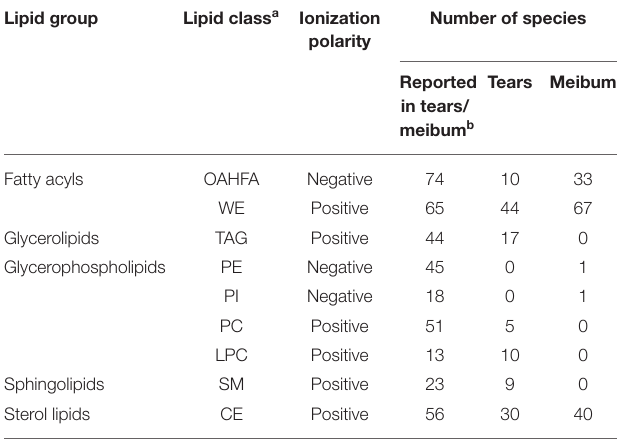
TABLE 2 | Summary of the lipids detected in the tears or meibum by using MS/MS ALL . Lipid group